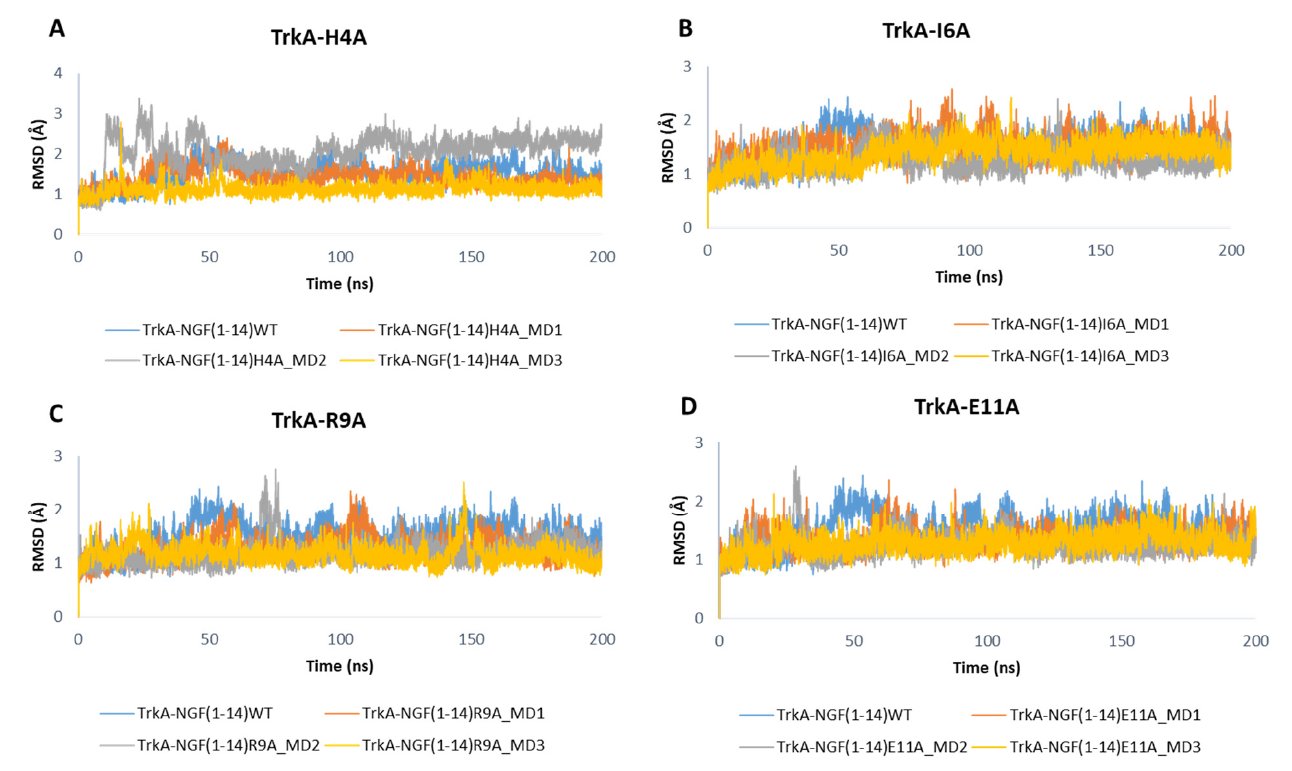
Figure 9. RMSD profiles of the backbone of NGF(1–14) mutants H4A ( A ), I6A ( B ), R9A ( C ) and E11A ( D ) obtained for each MD run.